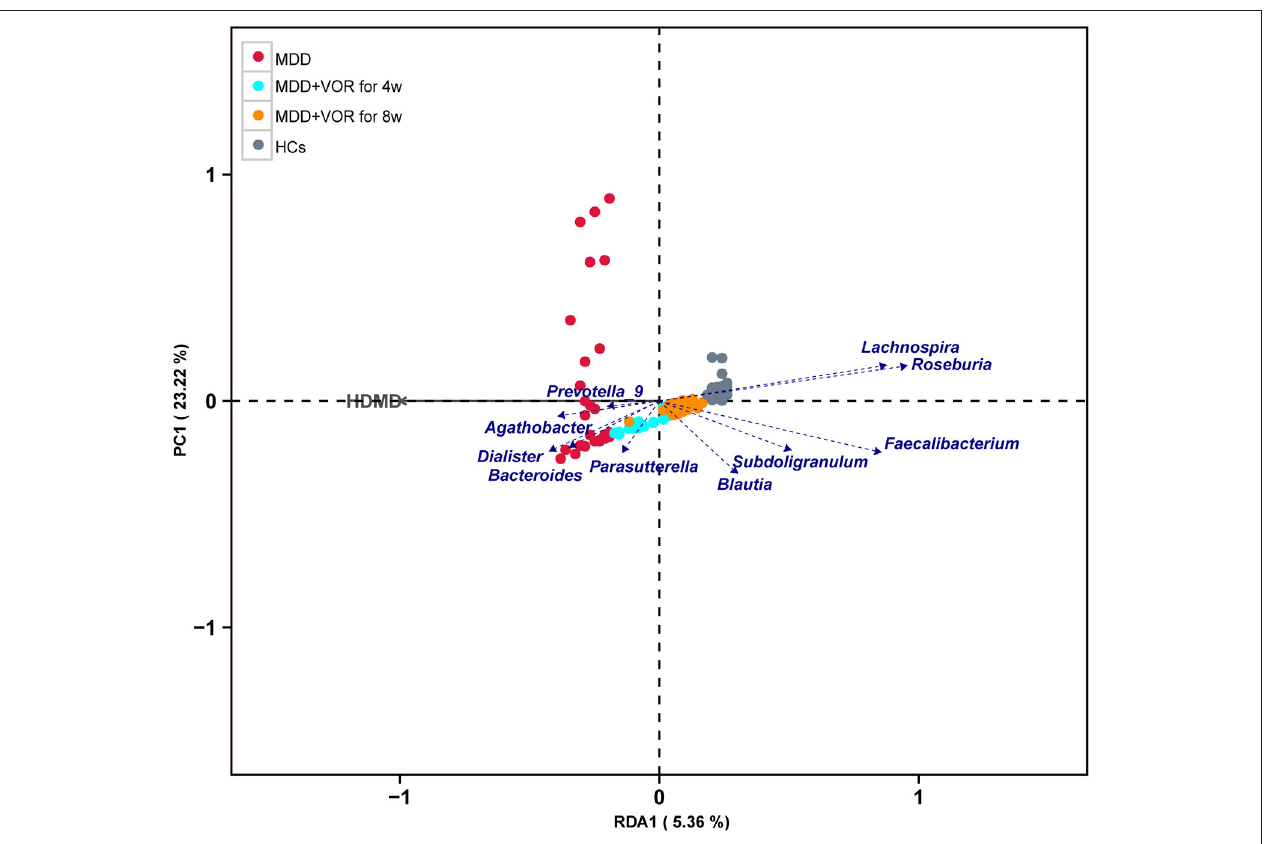
FIGURE 6 | Correlations between fecal microbiota and HAMD